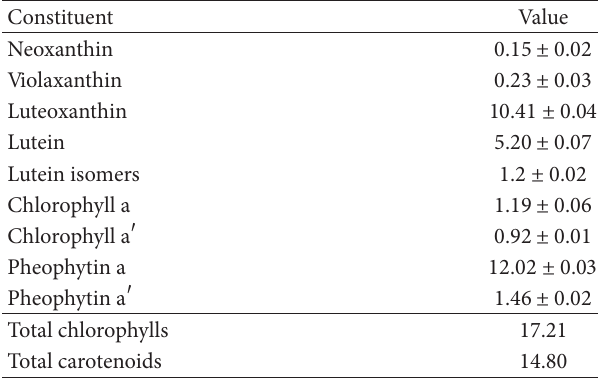
T 6: Levels of Pistacia atlantica pigment